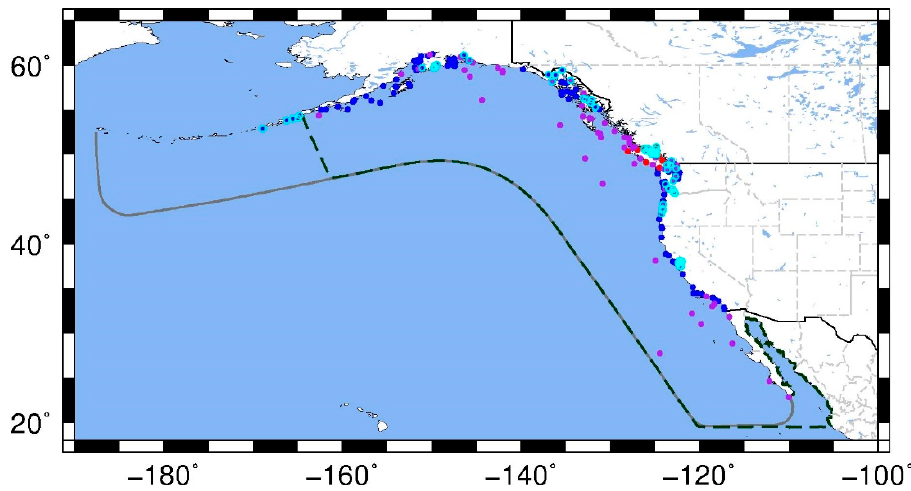
Figure 6. Locations of the 258 available validation stations shown with the ENPAC03 boundary (dashed dark green) and ENPAC15 boundary (gray); stations from three sources: CO-OPS (blue), IOS-FOC (red), and IHO (purple) with dry stations denoted with a cyan circle. Zoomed regional views provided in Appendix A.